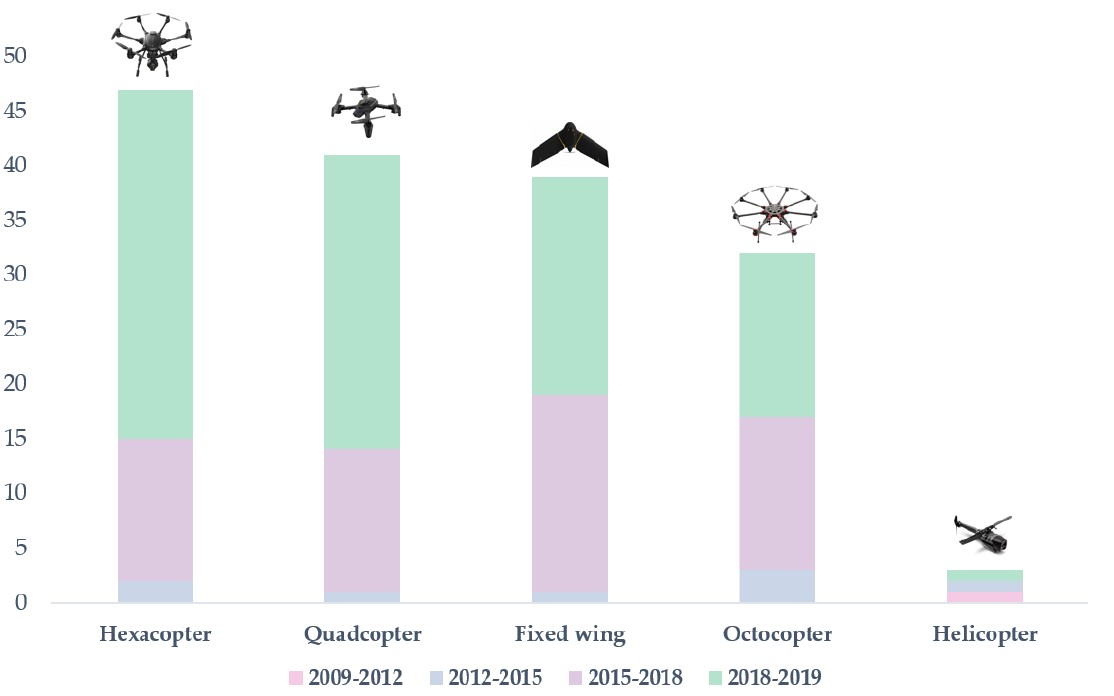
Figure 7. Frequency of platform types utilized in articles combined machine learning and statistical models and UAV imagery for the period 2000–2019.